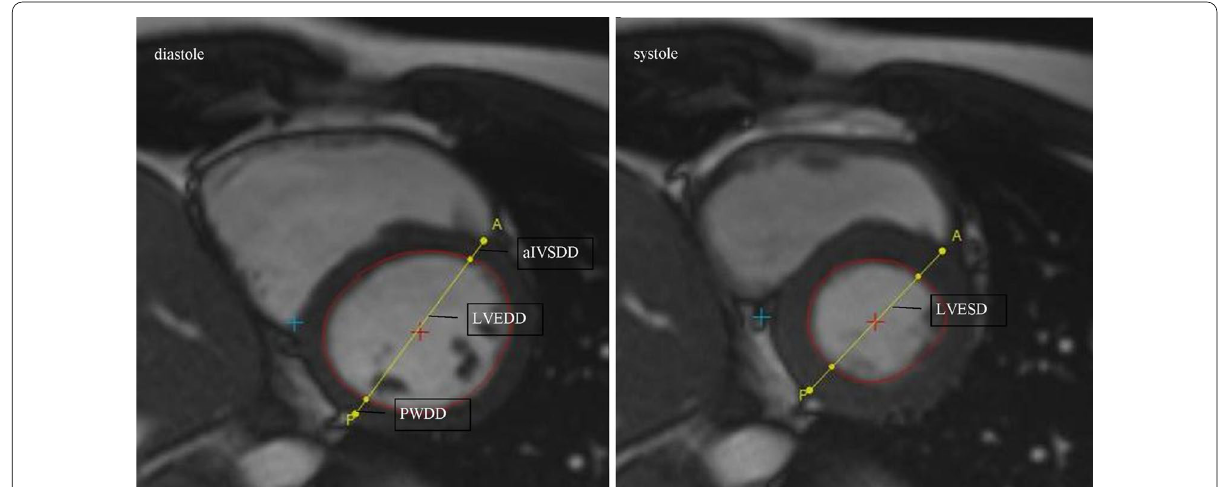
Fig. 3 The method of measuring aIVSDD, PWDD, LVEDD and LVESD in a short-axis CMR